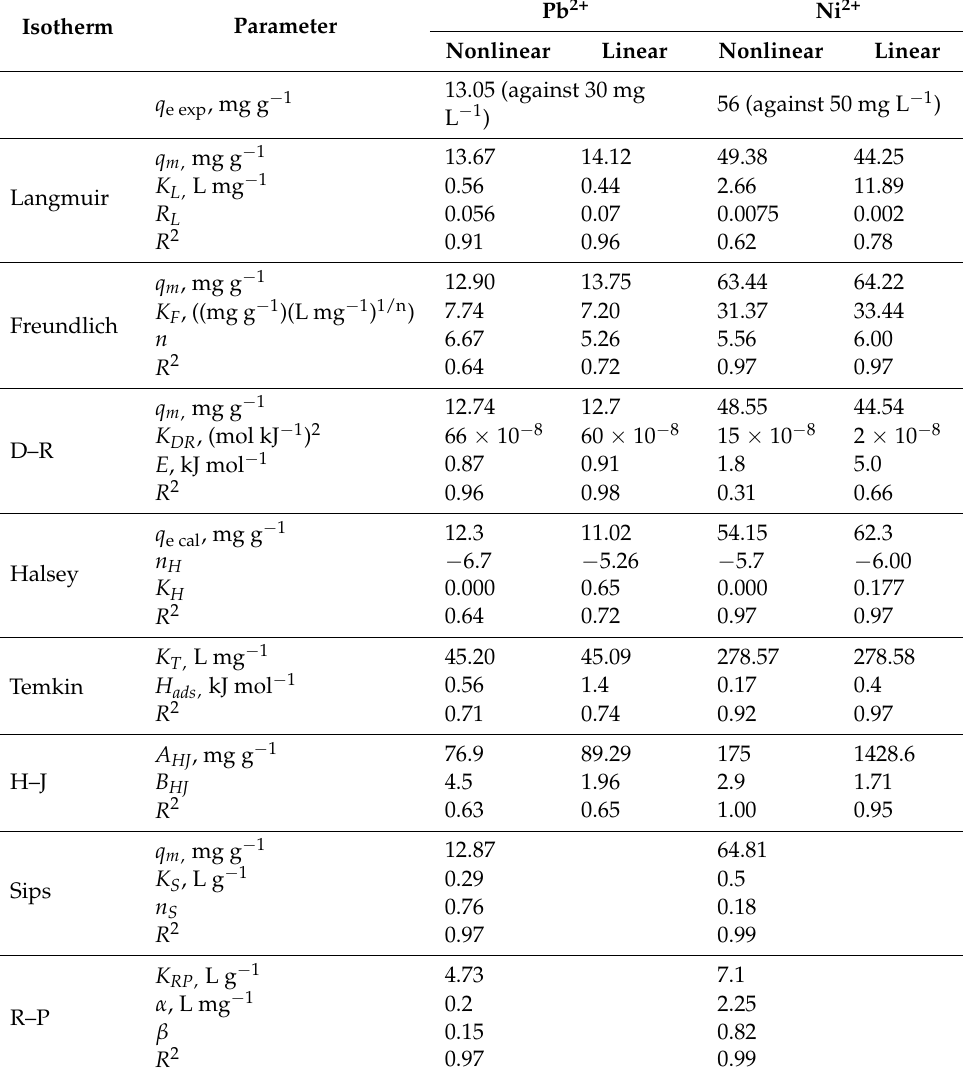
Table 4. Estimated parameter values in the nonlinear and linearized isotherm models for Pb 2+ and Ni 2+ (contact time = 60 min, PANmod dose= 0.5 g, pH = 5 ± 0.2 and 7 ± 0.2 for Pb 2+ and Ni 2+ ,